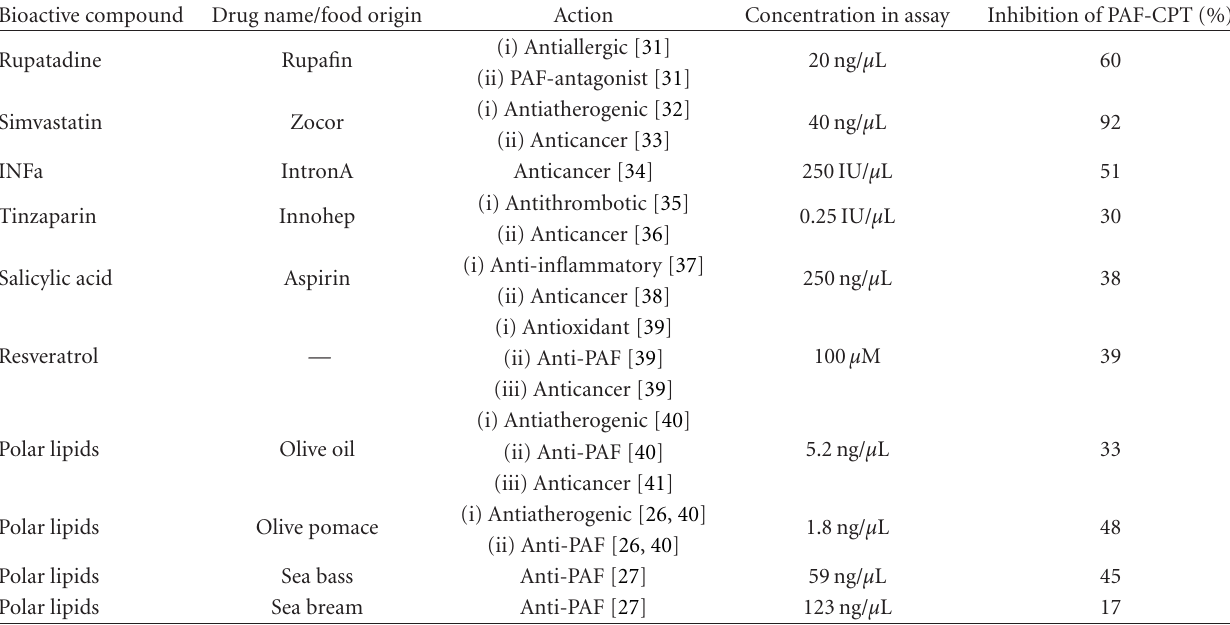
Table 4: In vitro e ff ects of various drugs and bioactive compounds of Mediterranean diet on PAF-CPT activity of HMC. Preliminary results represent the average of two independent experiments using di ff erent enzyme preparations performing duplicate samples. Results are expressed as percentage of inhibition of PAF-CPT activity versus control (absence of these